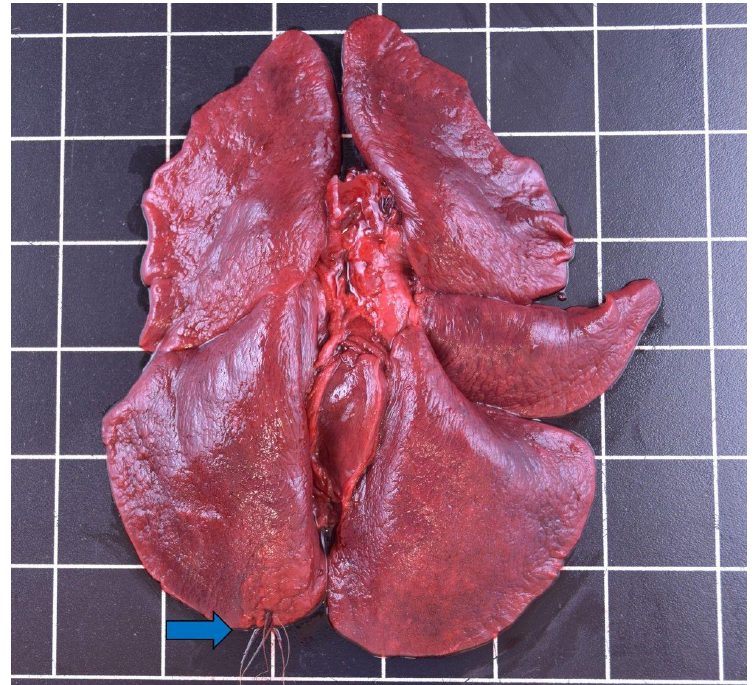
Figure 3. Plant fibers (blue arrow) perforating the lung of a male otter from Schleswig-Holstein. Bronchopneumonia was seen in two males of an unknown age, in one case together with intralesional fungal spores (Figure 4). An additional female (2.5–4.5 years) likewise showed bronchopneumonia with intralesional structures suggesting adiaspores [55]. Using a broadrange PCR assay fungal DNA of the typical agent of Adiaspiromycosis, Adiaspiromyces could not be amplified, probably due to inhibition of the PCR, a frequent problem in formalin-fixed and paraffin-embedded tissue, and the presence of other fungal DNA from different potentially contaminating fungi.